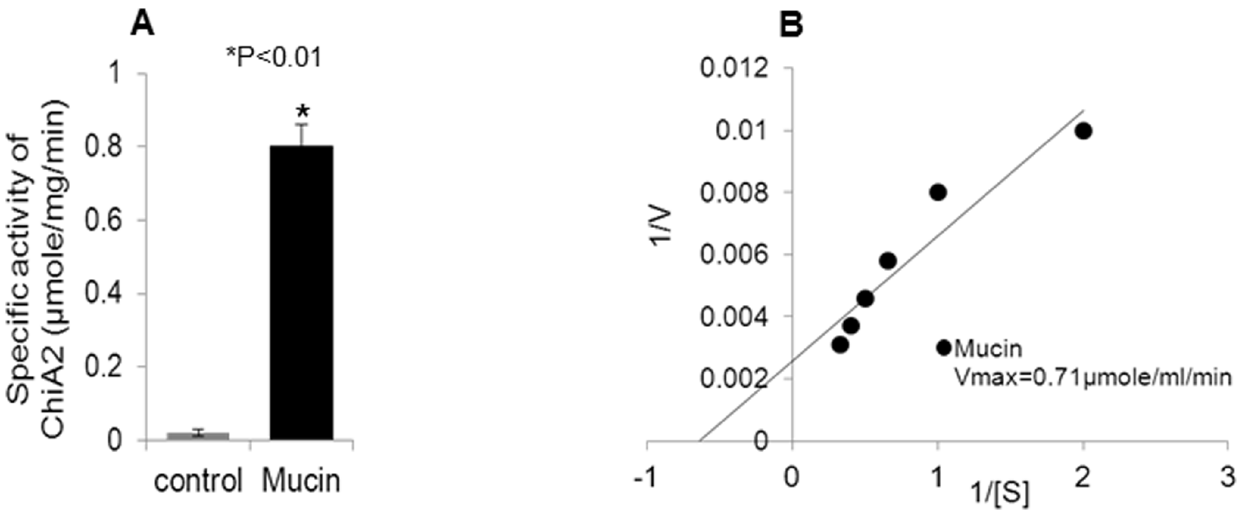
Figure 1. ChiA2 can use mucin as a substrate. A . This diagram shows the specific activity of ChiA2 when mucin was used as substrate. In the control experiment heat inactivated ChiA2 was used instead of active ChiA2. The assay was done as described in materials and methods. The experiment was repeated thrice (n=3) and the data expressed as means 6 SEM. B . This figure shows the Lineweaver Burk plot of ChiA2-mucin reaction. The plot was generated by plotting inverse of different substrate (mucin) concentrations (0.5 mg/ml, 1 mg/ml, 1.5 mg/ml, 2 mg/ml, 2.5 mg/ ml and 3 mg/ml) in the X-axis and inverse of each reaction velocity in Y axis.